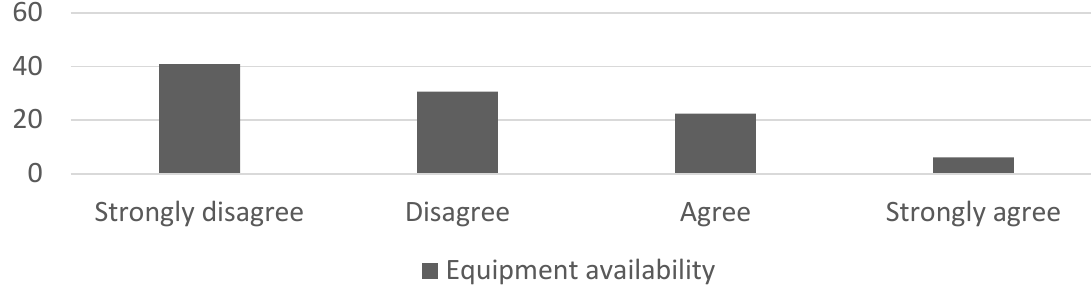
Figure 5. Equipment